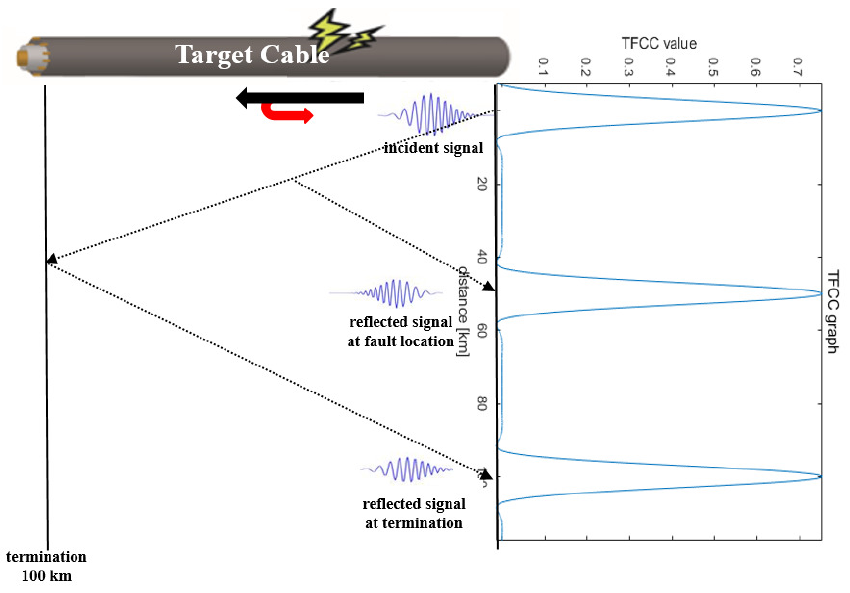
Figure 11. The basic conceptual diagram of